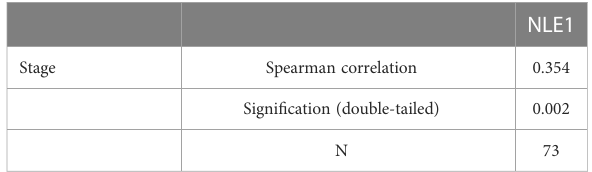
TABLE 3 Relationship between NLE1 expression and tumor characteristics in patients with non-small cell lung cancer.